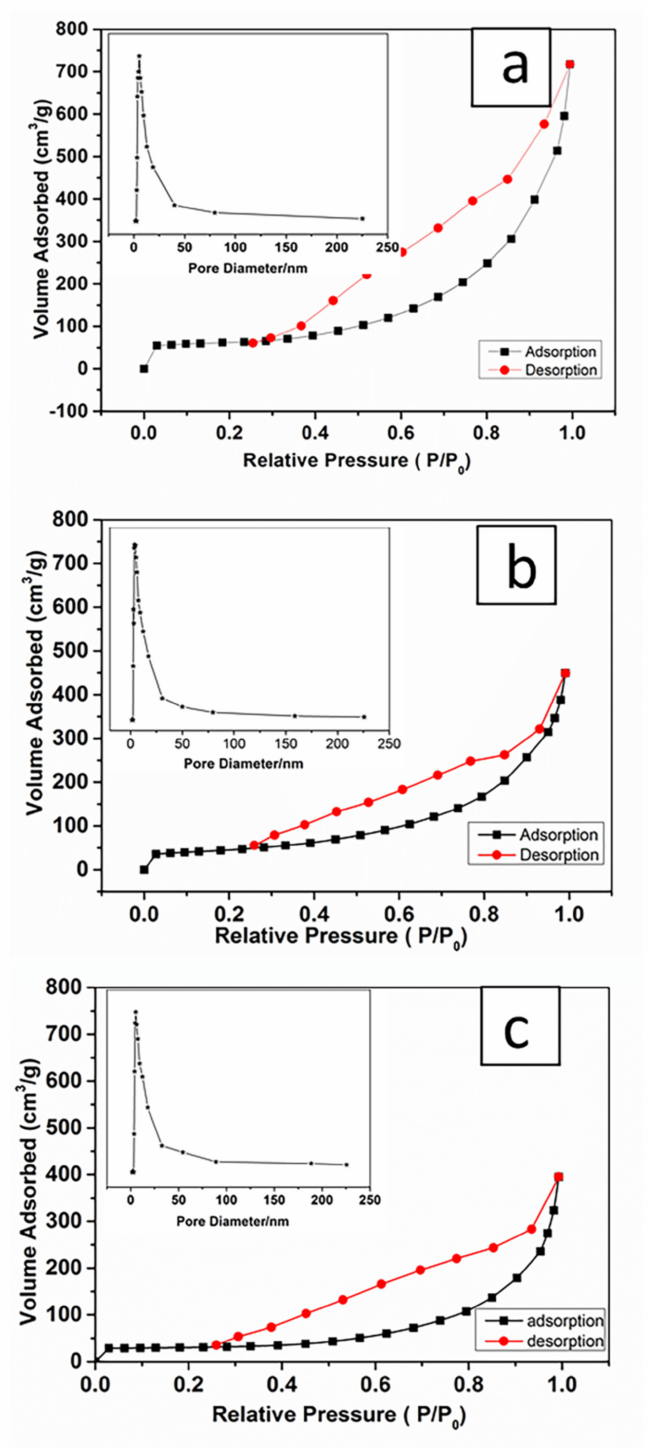
Figure 7. N 2 adsorption–desorption isotherms of ( a ) MSNTs-1, ( b ) MSNTs-2, ( c ) MSNTs-3. The insert was the Barrett–Joyner–Halenda (BJH) pore size distribution plot of corresponding MSNTs. Figure 8 shows the release profiles of lysozyme from different lysozyme-loaded MSNTs (lysozyme-loaded MSNTs-1, lysozyme-loaded MSNTs-2 and lysozyme-loaded MSNTs-3 named as MSNTs-1-LYS, MSNTs-2-LYS, MSNTs-3-LYS). The release of lysozyme from the lysozyme-loaded MSNTs was divided into three stages: a burst release in the first 2 h, a moderate release between 2 and 270 h and stable slow release after 270 h. In the first